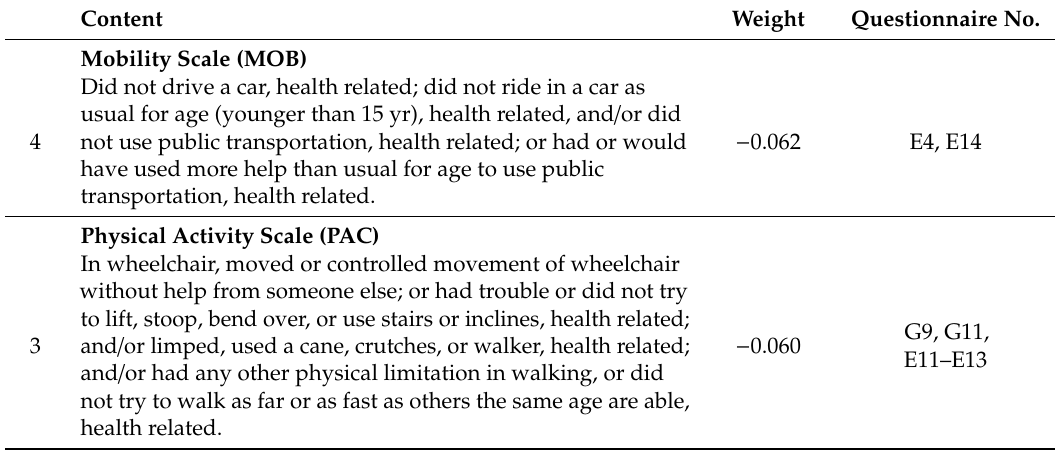
Table 2. Quality of Well-Being (QWB) scale items weights and corresponding number of the CLHLS